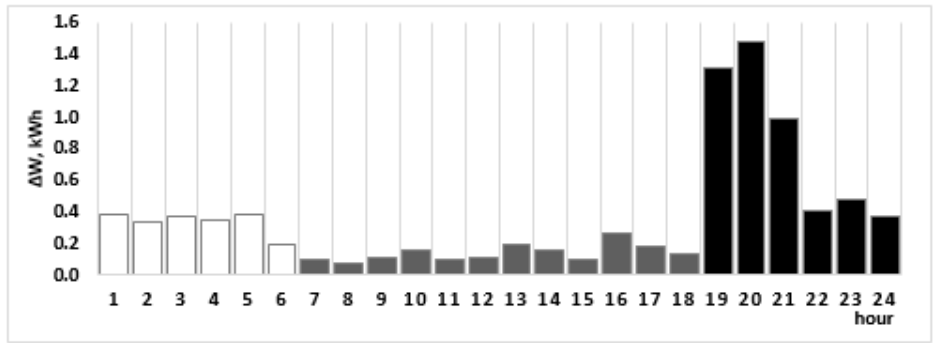
Figure 7. The active energy losses in the reference case.